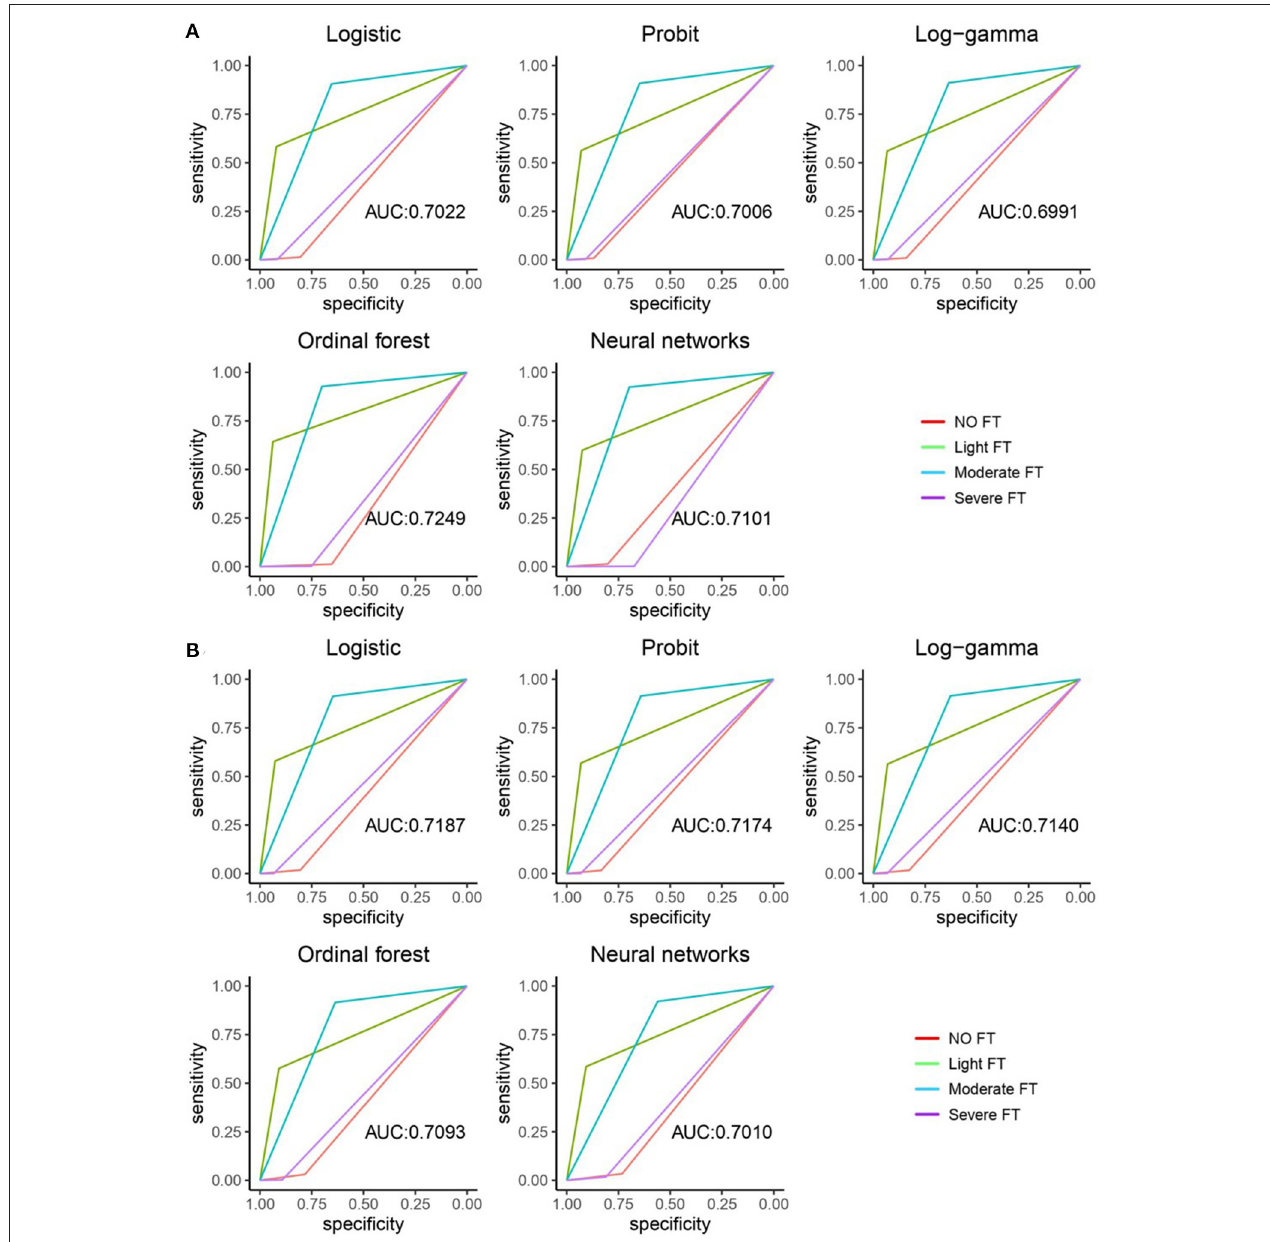
FIGURE 1 | ROC curve and AUC value of five machine learning methods. (A) The in-sample ROC curves and AUC values of the five machine learning methods. (B) The out-sample ROC curves and AUC values of five machine learning